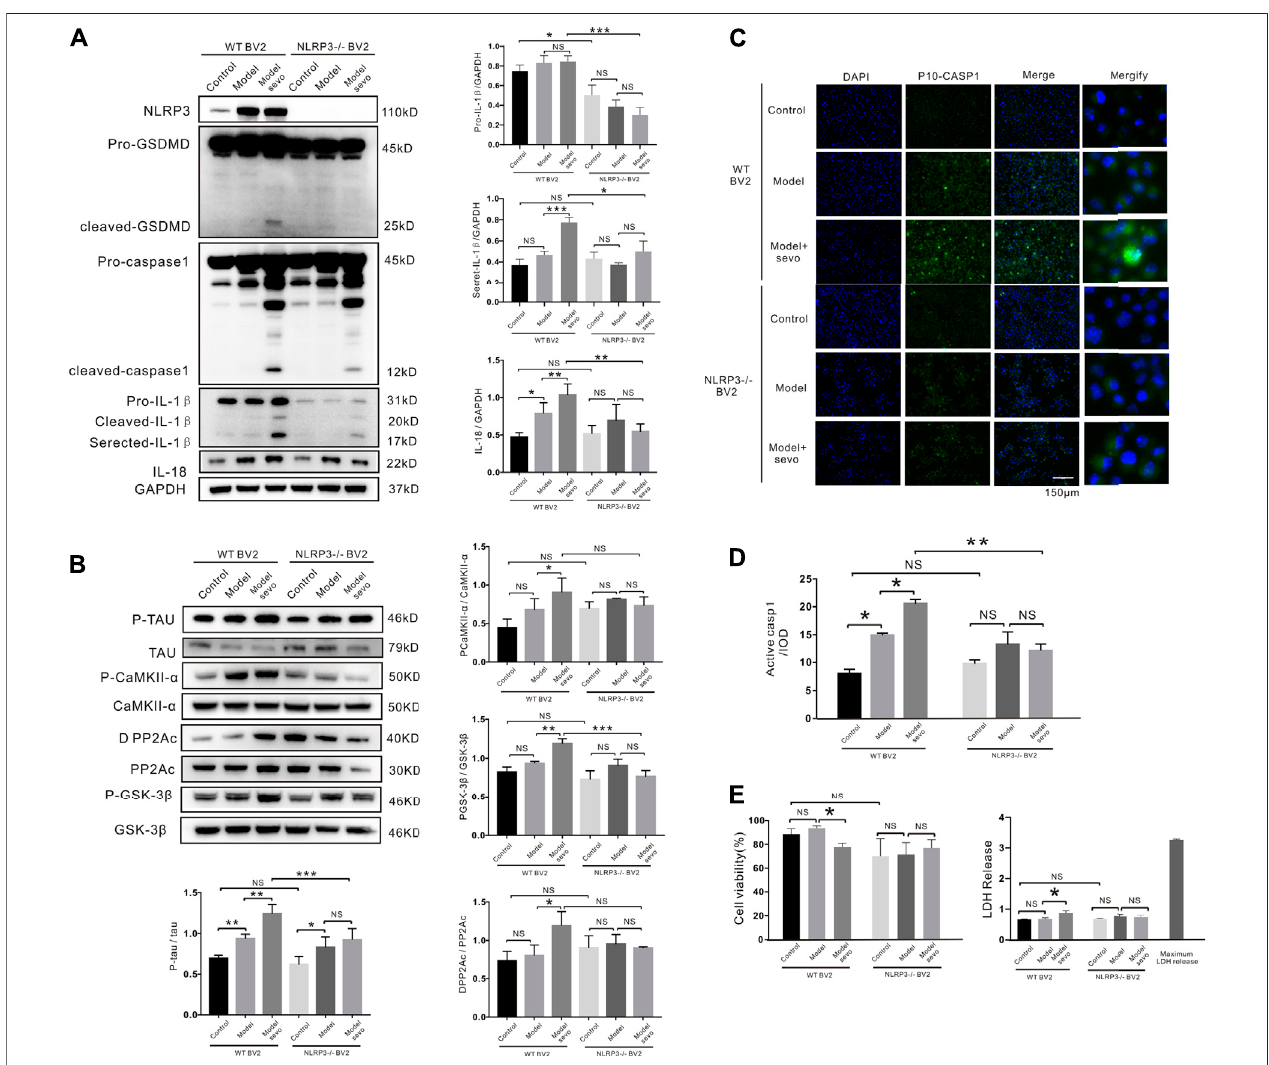
FIGURE5| NLRP3knockoutalleviatessevo fl urane-inducedpyroptosis. (A) WesternblottinganalysisofcleavedgasderminD(GSDMD),cleavedcaspase-1,IL-1 β , and IL-18 induced by sevo fl urane in wild-type (WT) and NLRP3 − / − BV2 cells. Protein band intensity was quanti fi ed using ImageJ software. (B) Immunoblot analysis of p-tau,tau-correlated kinases,andphosphatasesinducedbysevo fl uraneinWTandNLRP3 − / − BV2cells. (C) FAM-FLICAcaspase-1assayofcleavedcaspase-1(green) induced by sevo fl urane in WT and NLRP3 − / − BV2 cells. Scale bar: 50 μ m (D) . Quantitation of cleaved caspase-1 fl uorescence intensity as iod. (E) . Lactate dehydrogenase (LDH) release and Cell Counting Kit-8 (CCK-8) assays of LDH activity and cell viability induced by sevo fl urane in WT and NLRP3 − / − BV2 cells. *** p < 0.001, ** p < 0.01, * p <